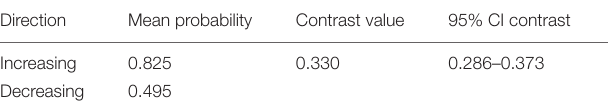
TABLE 6 | The direction contrast in experiment